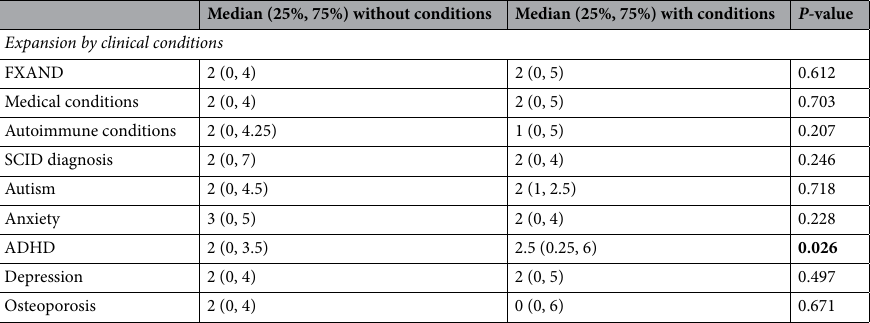
Table 2. Expansion by clinical conditions. a P -values are from Wilcoxon rank-sum tests; FXAND: Fragile X- associated neurodevelopmental disorders, SCID: Structured Clinical Interview for DSM-5, ADHD: attention deficit hyperactivity disorder.